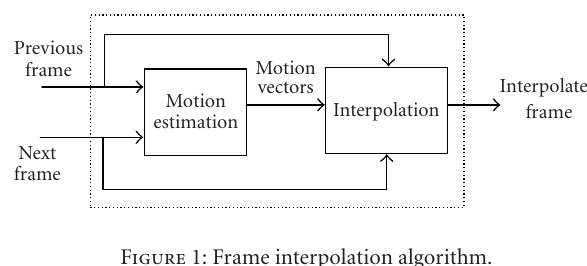
Figure 1: Frame interpolation algorithm.